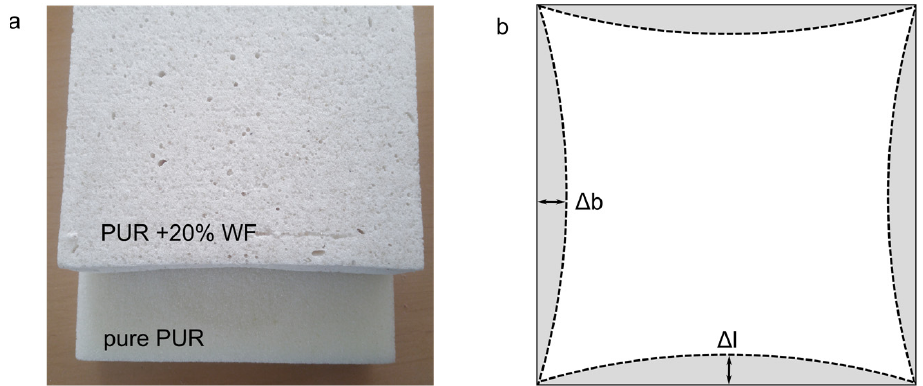
Figure 7. Deformation of pure PUR foam and foam with 20% WF after conditioning: ( a ) images of the tested foams, ( b ) scheme of PUR/WF foam linear dimension changes. ∆ b, ∆ l—changes in the width and length of the foams, respectively.